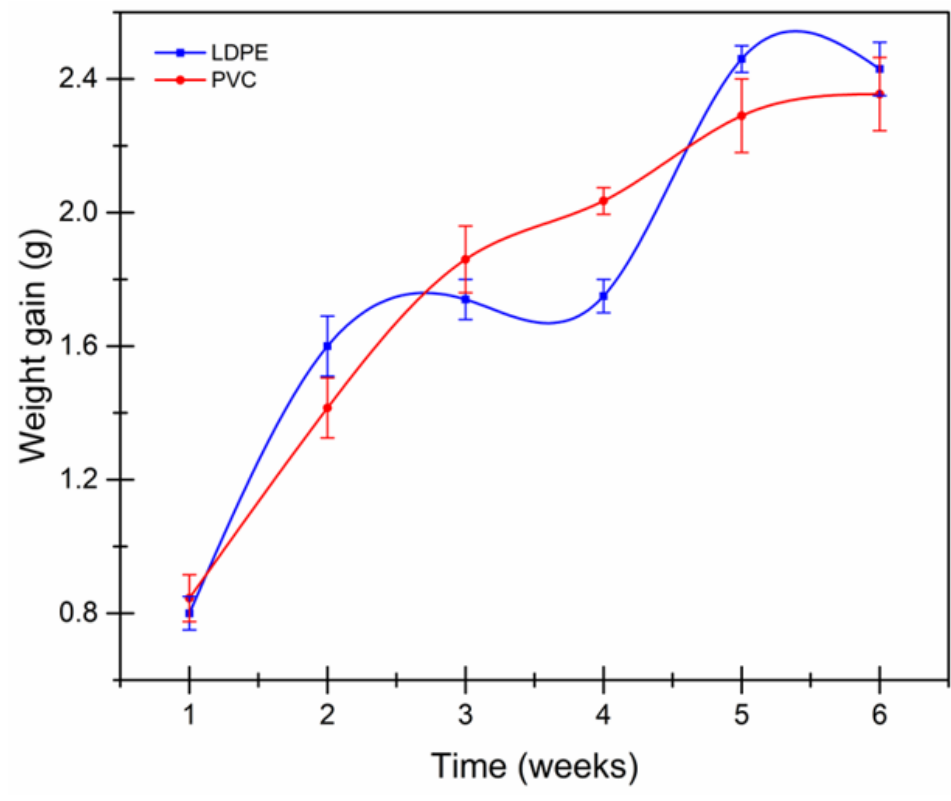
Figure 1. Weight gain behavior of LDPE and PVC films.